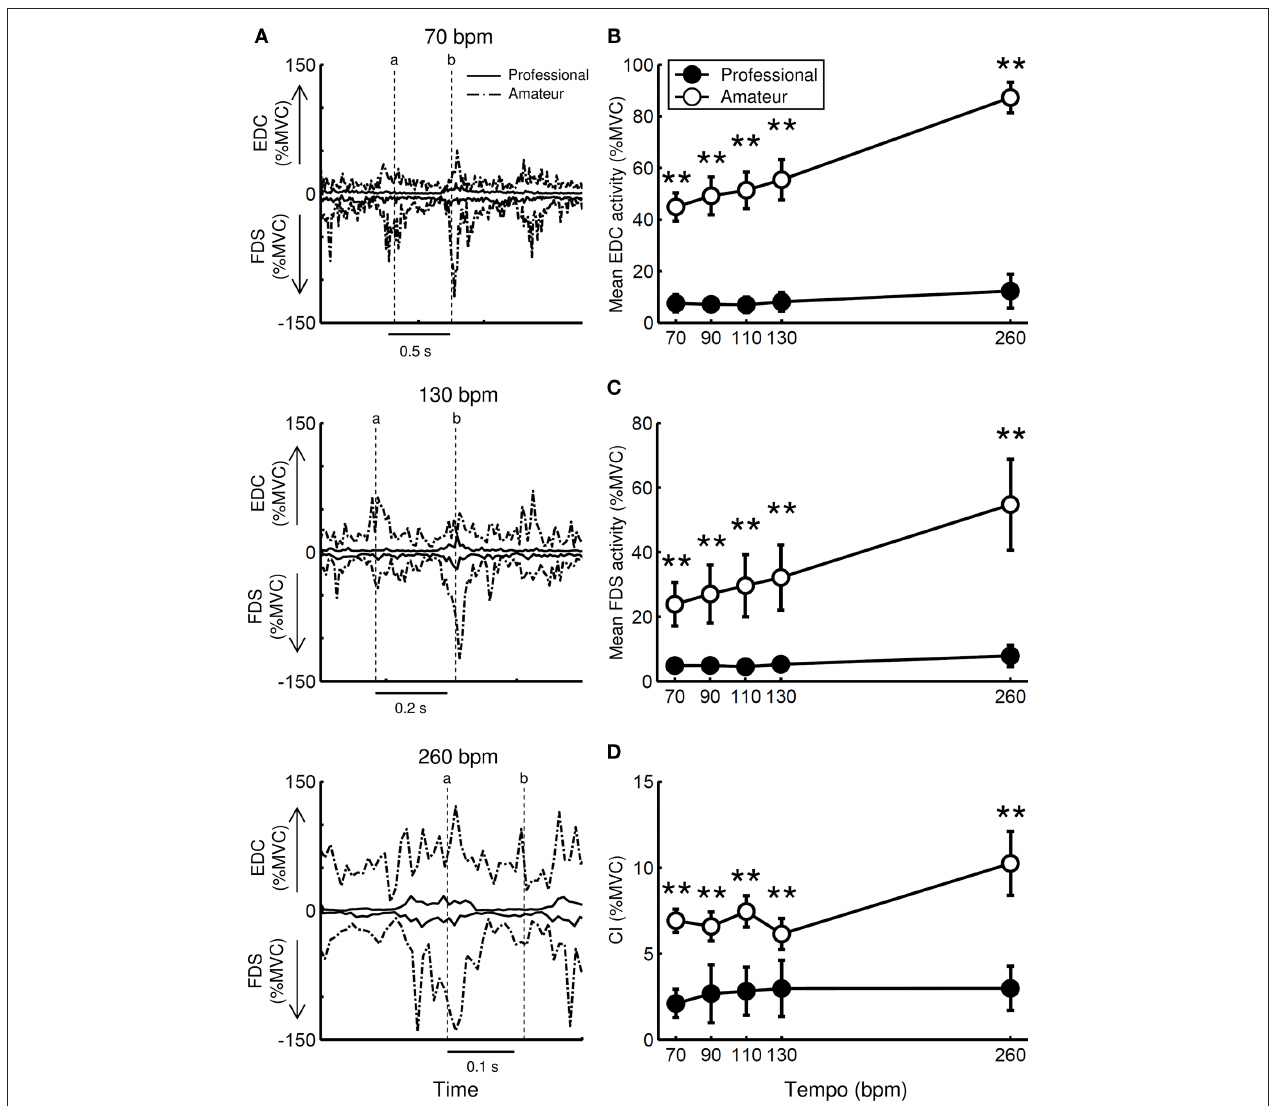
contacts the little finger (a) and the thumb (b). (B–D) Group means of the mean activity at the EDC (B) and FDS (C) muscles and the co-activation index (CI) of these muscles (D) at five striking tempi for professional (filled circle) and amateur (open circle) pianists. Error bars represent ± 1 SE ( n = 5). * p < 0.05, ** p